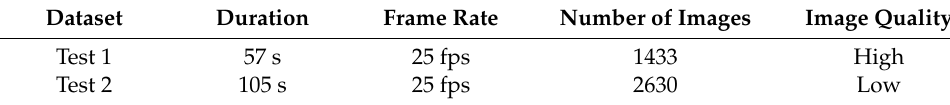
Figure 4. Partial results of decomposition of video data into images. ( a ) Partial results of Test 1 data decomposition; ( b ) Partial results of Test 2 data decomposition. Table 2. Details of the two datasets.